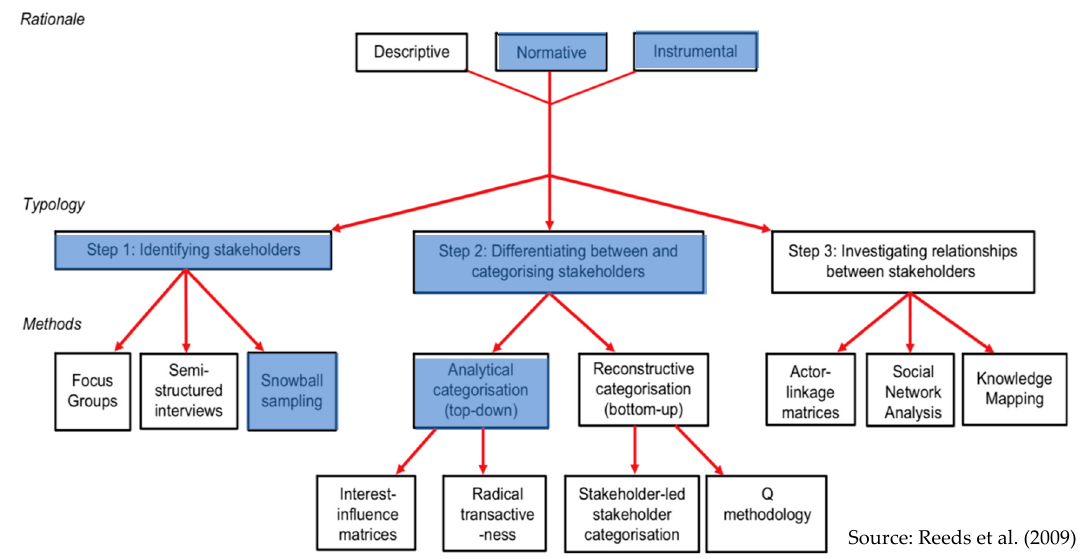
Figure 2. Schematic representation of the stakeholder analysis rationale, typology and methods according to Reeds et al. (2009) [9]. The procedures adopted in this research are highlighted in blue.